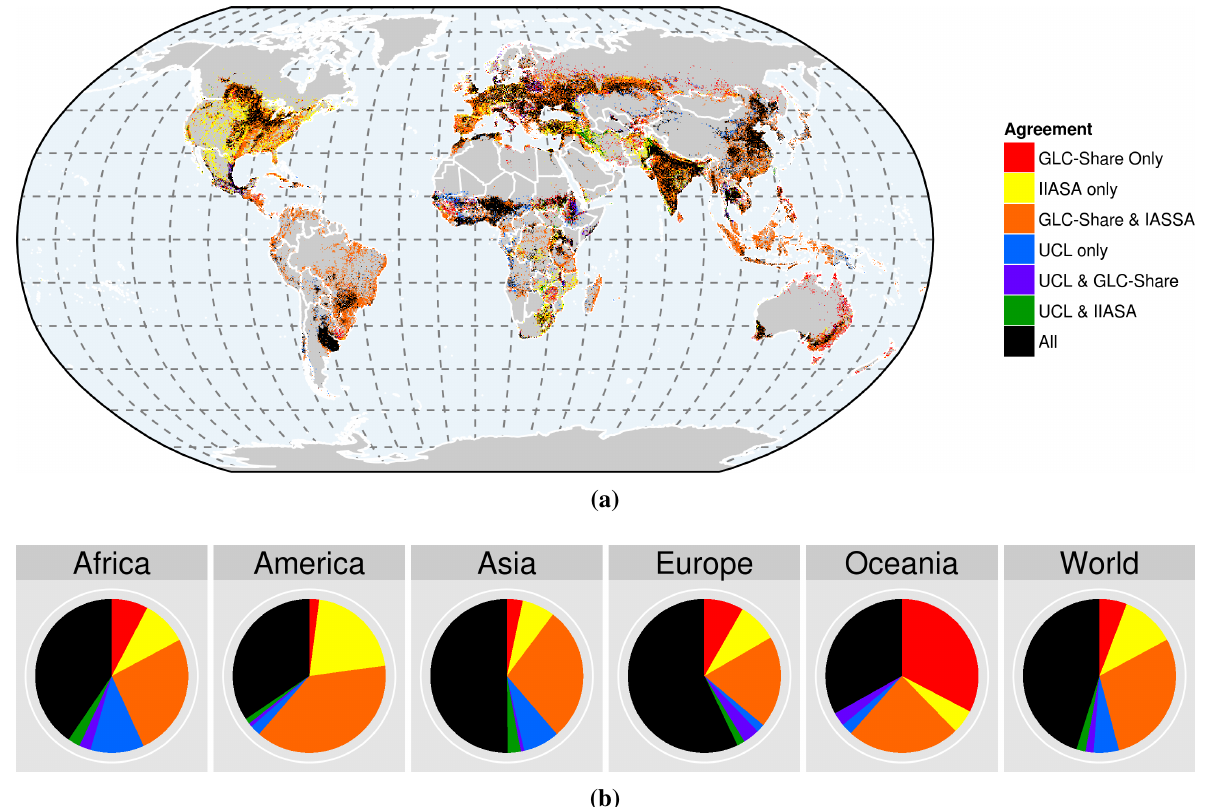
Figure 7. Agreement map between GLC-Share, the IIASA Cropland and the unified cropland layer (UCL). ( a ) Spatial agreement and ( b ) agreement proportions at the continental level. Large cropland disagreements are evident in Southeast Asia, North America and South America, as well as some African countries. A significant part of the disagreements might be due to the different legends chosen. Previous priorities are confirmed: Southeast Asia (Indonesia and Vietnam), South America (Brazil and Colombia) and African countries (e.g., western and southern countries and